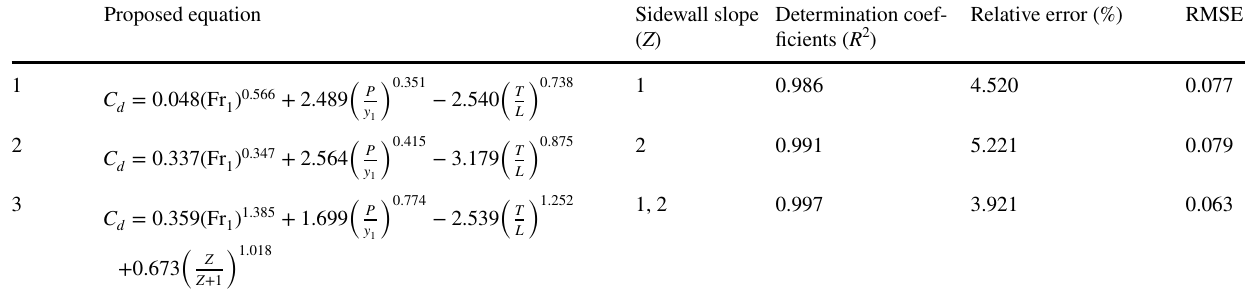
Table 5 Sensitivity analysis for the general equation of discharge coefficient